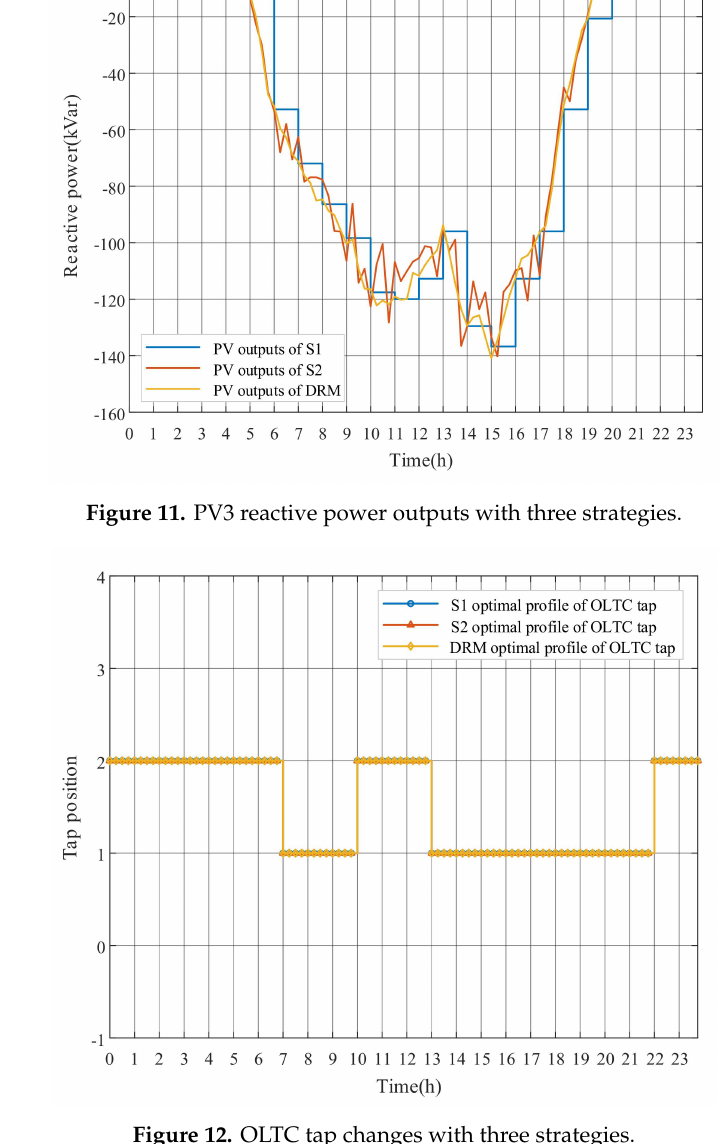
Figure 12. OLTC tap changes with three strategies. Table 4. Adjustment costs of three